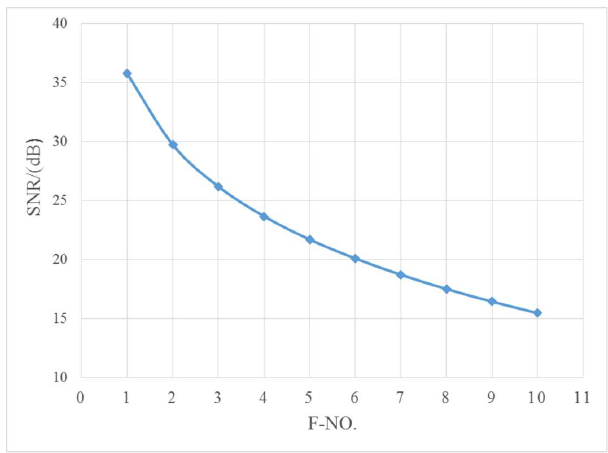
Figure 3. Relationship between SNR(signal to noise ratio) and F-No. of optical system.